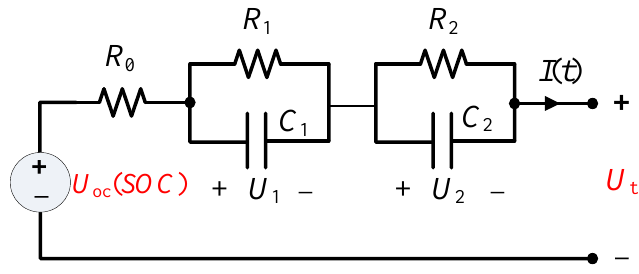
Figure 1. Schematic diagram of the second-order RC model.